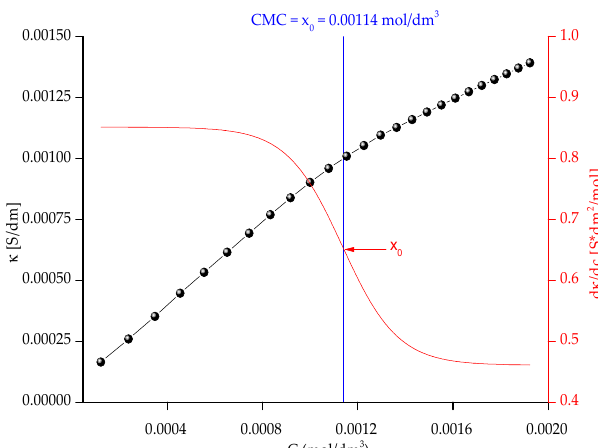
Figure 4. Specific conductivity (•) and differential conductivity Boltzman-type fitting ( ― ) vs. concentration of P17 at 25 °C.